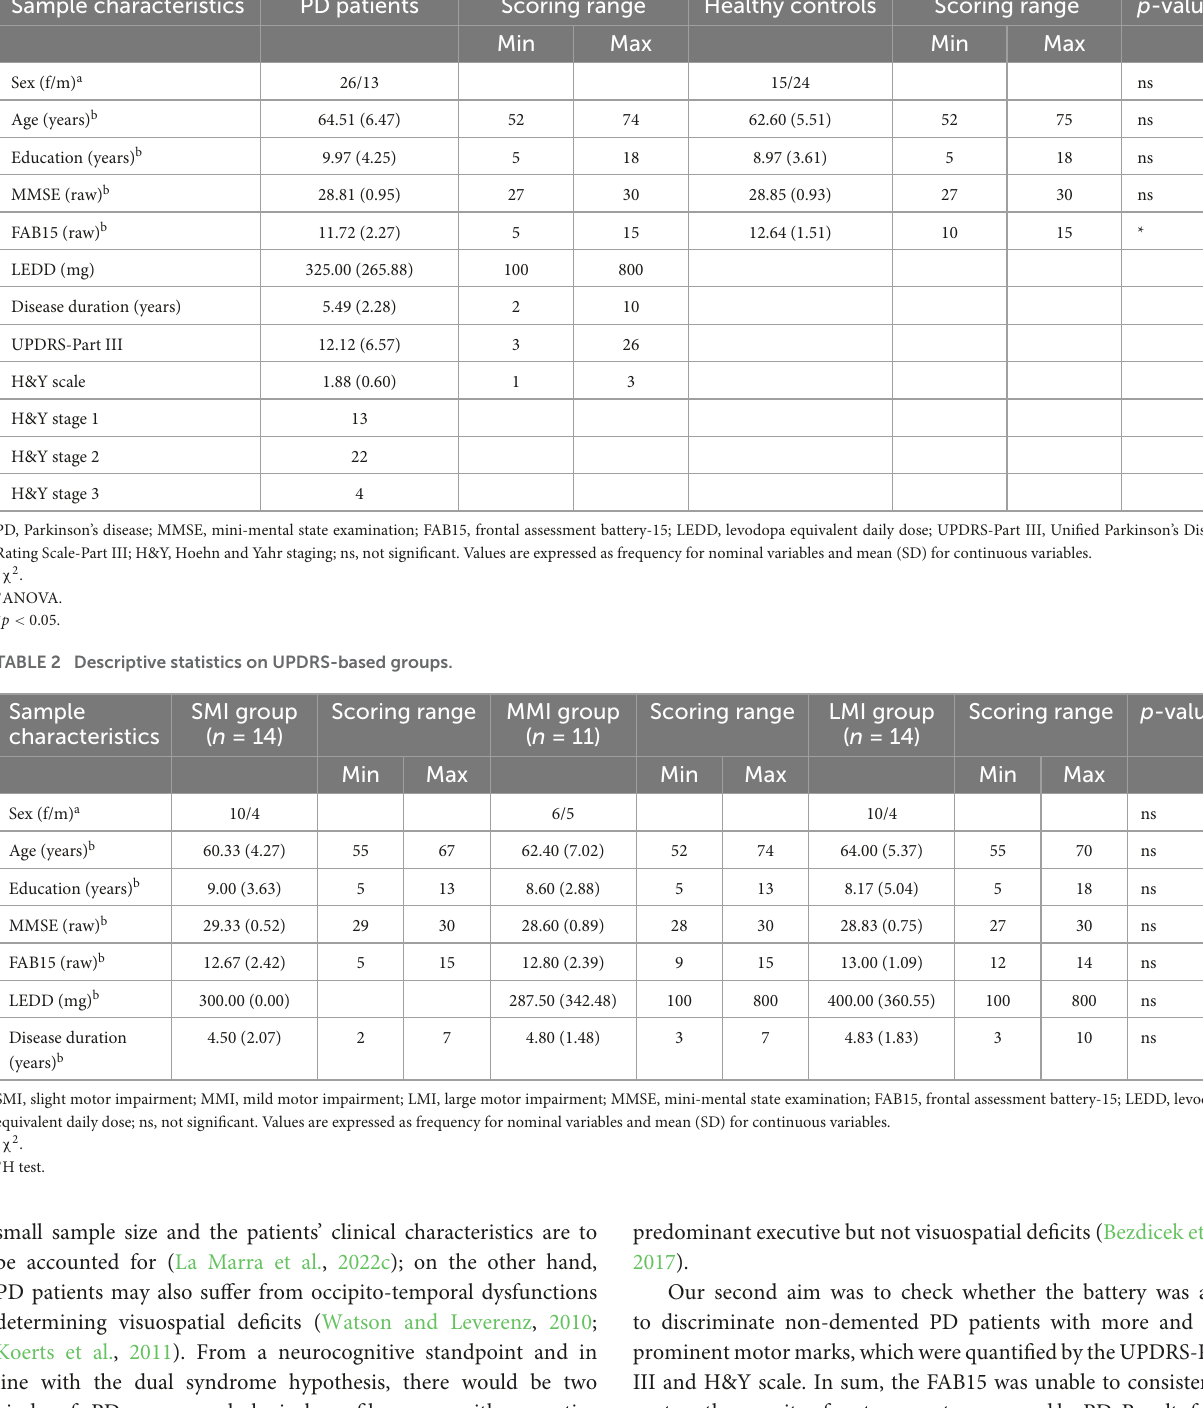
TABLE 1 Descriptive statistics concerning the patient and control group. Sample characteristics